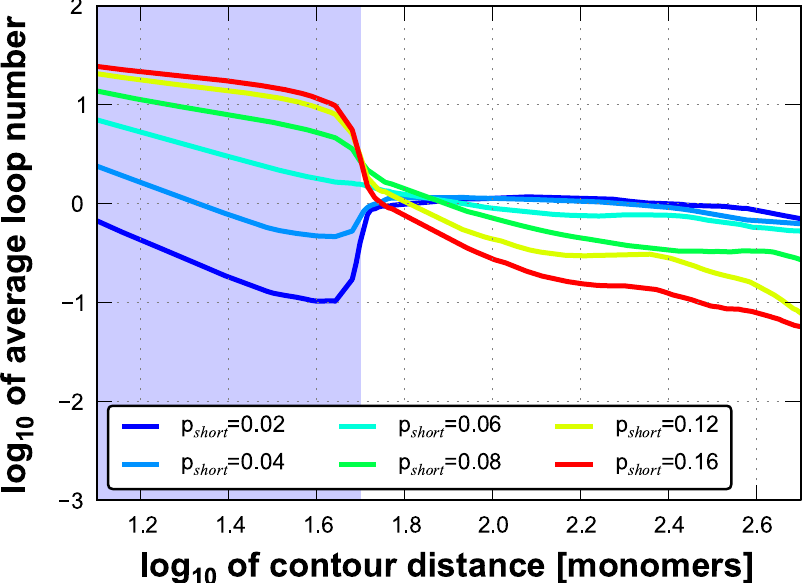
Figure 6. Relationship between looping probability and number of established loops. When keeping the long-range looping probability (p long ) constant while varying short-range looping probability (p short ), the number of long-range loops (n long ) increases when reducing p short . This is because lowering p short reduces the loop repulsion on the short scale and hence increases intermingling on the long scale, which in turn increases the frequency of long-range loop formation. Here, p long =0.06 and p short is varied from 0.02 to 0.16. The blue area marks the short-range looping regime ( , 50 monomers) while the rest describes the long-range